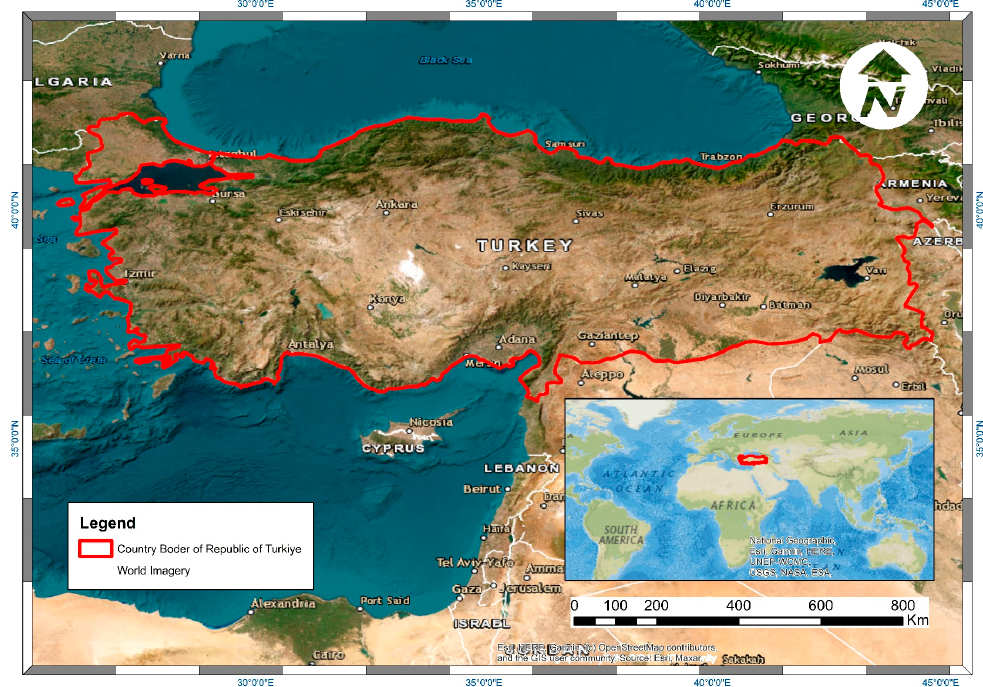
Figure 1. Geographic location and borders of the Republic of Türkiye (study area) (ESRI World Imagery Basemap).